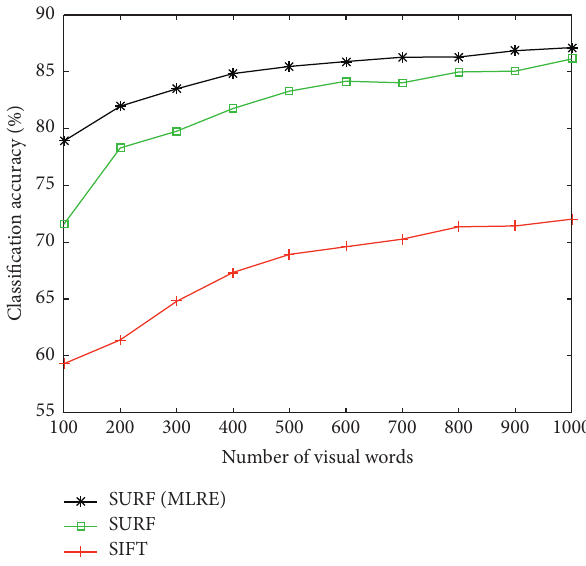
Figure 7: Effects of multiscale local region extraction on